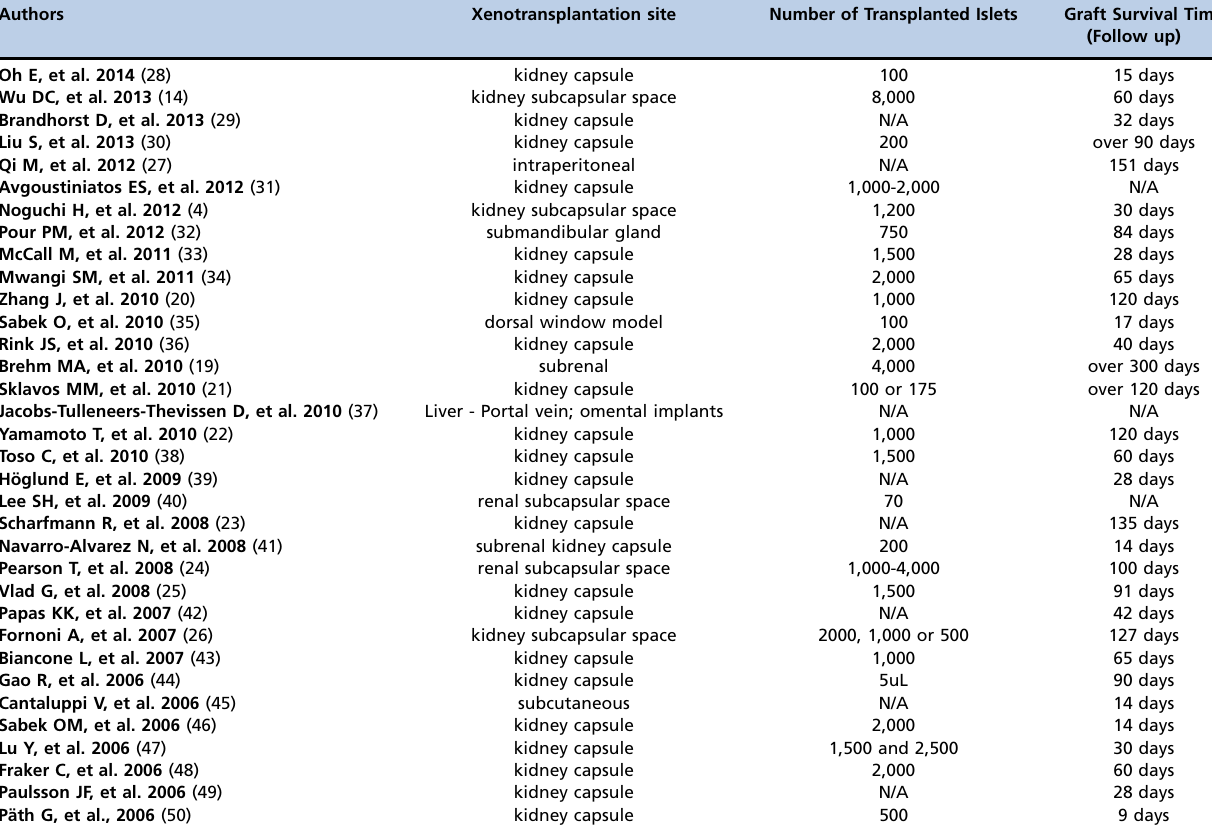
Table 2 - Preferred islet xenotransplantation site, number of transplanted islets and graft survival time (follow